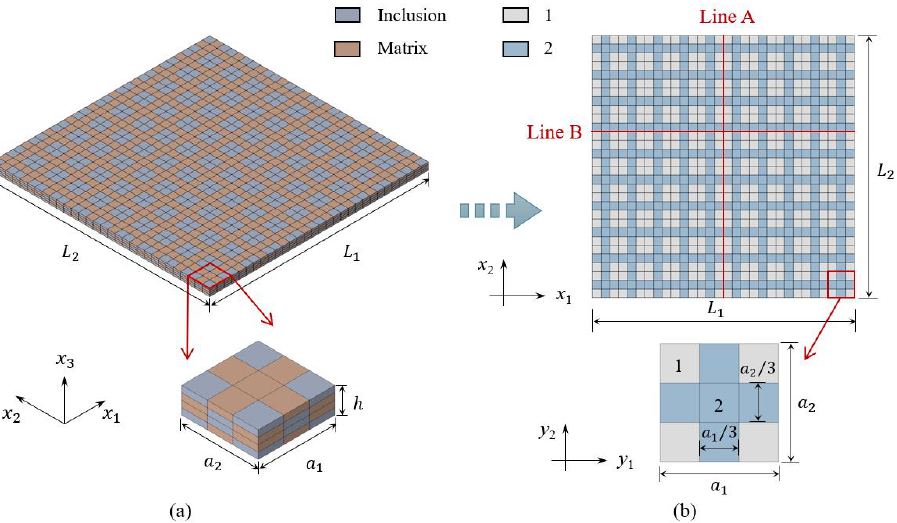
Figure 1. 3D periodic plate and its corresponding 2D Kirchhoff plate. ( a ) 3D periodic plate with multi-inclusion; ( b ) 2D periodic plate with multi-inclusion and its unit cell.